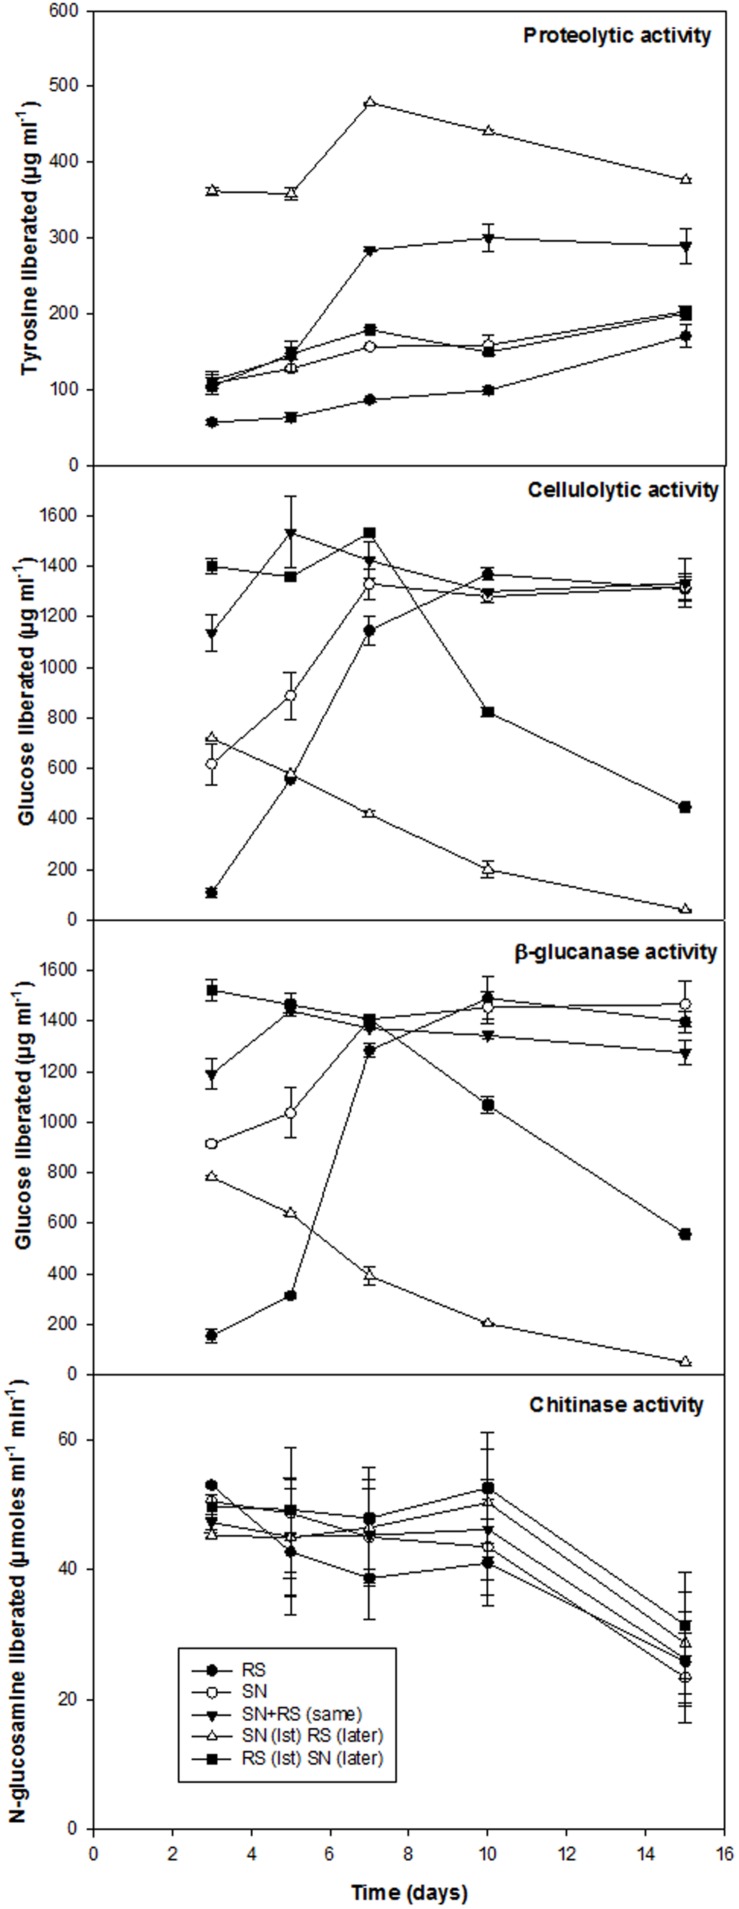
Enzymatic profile of medium supernatant during in vitro interactions of SN13 and R. solani.